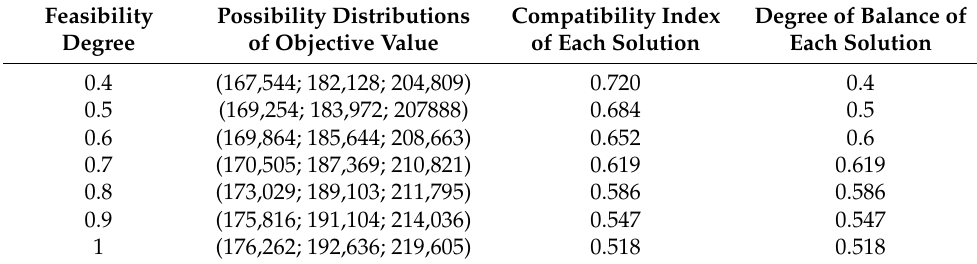
Table 16. α -acceptable optimal solutions.